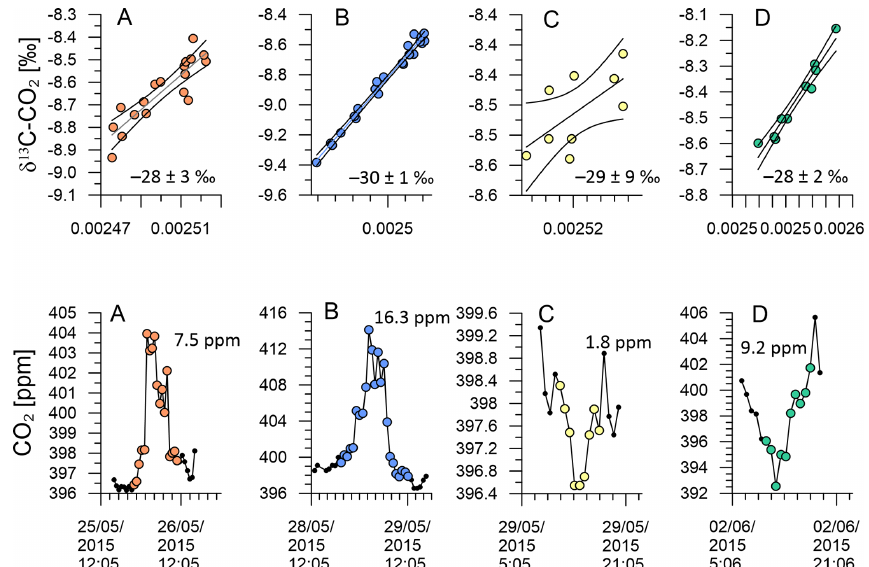
Figure 15. KPA with 95% confidence interval and standard error for the intercept of A–D (top). CO 2 variation of events A–D